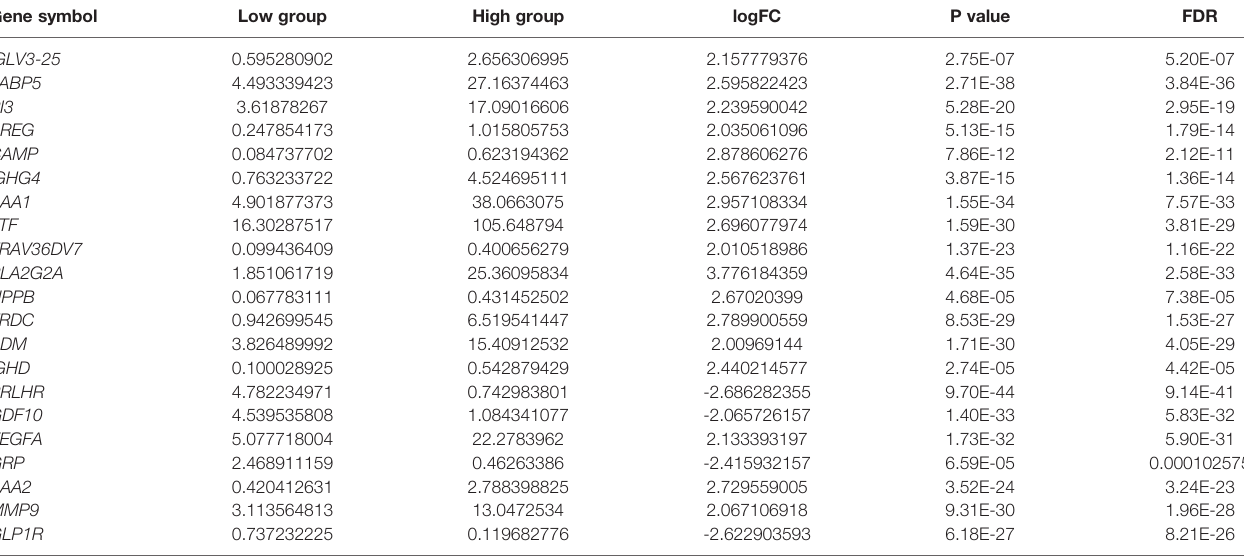
TABLE 1 | Immune-related genes differentially expressed in low and high TMB groups. Gene